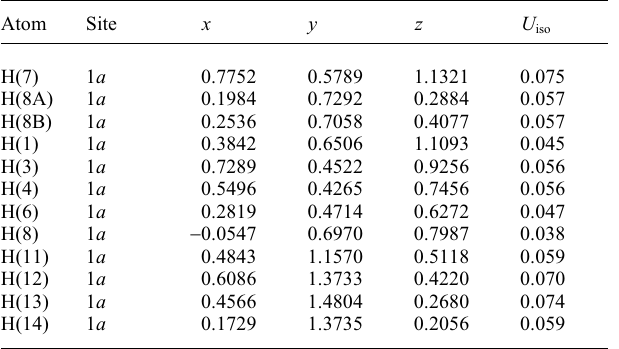
Table 2. Atomic coordinates and displacement parameters (in Å 2 )